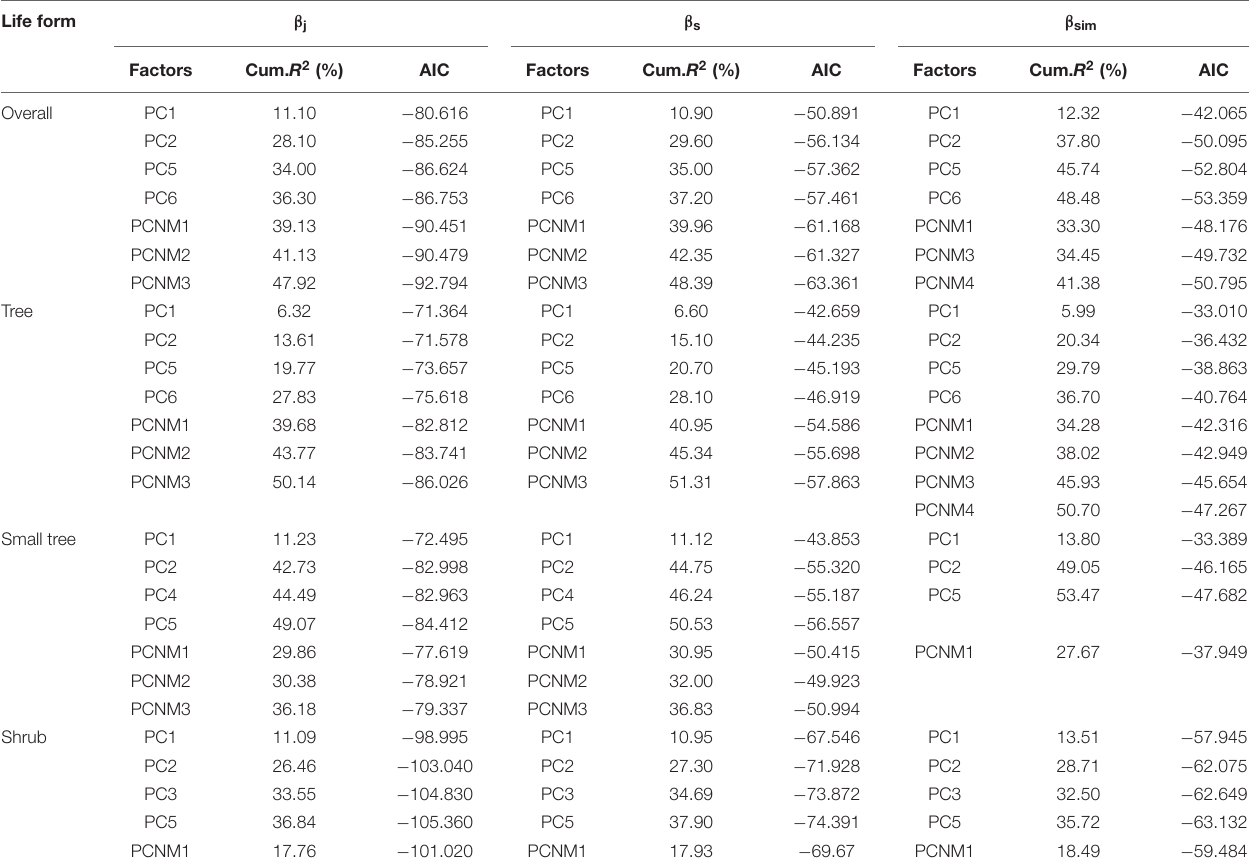
TABLE 2 | Relationships between β -diversity and PC variables or PCNM